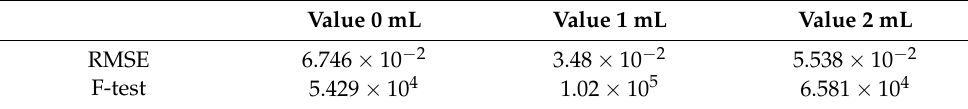
Table 5. Statistical evaluation of the determined parameters.